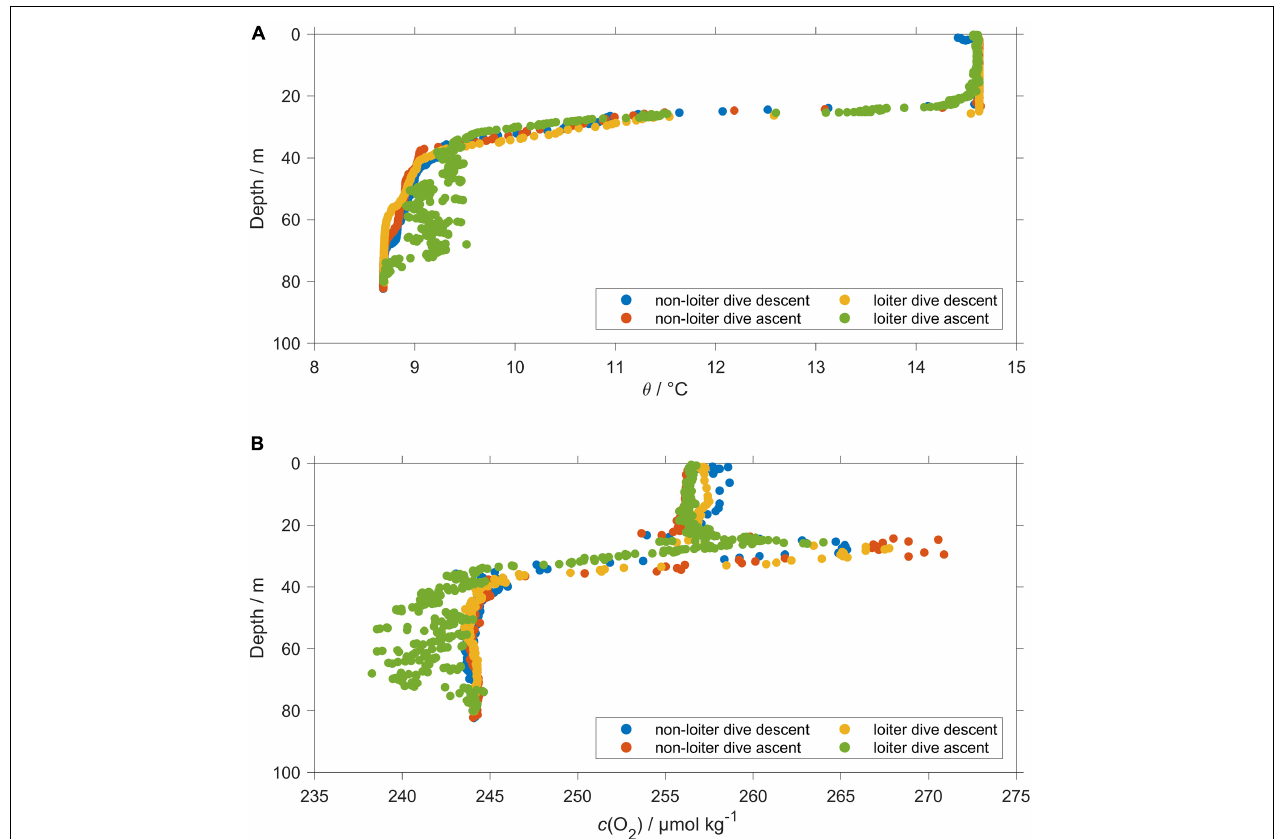
FIGURE 4 | Comparison between a normal dive (110) and a loiter dive (111). During dive 110 data were stable. During dive 111 the loiter dive caused abnormal readings for ascent temperature (A) θ and (B) O 2 content c (O 2 ) and conductivity (not